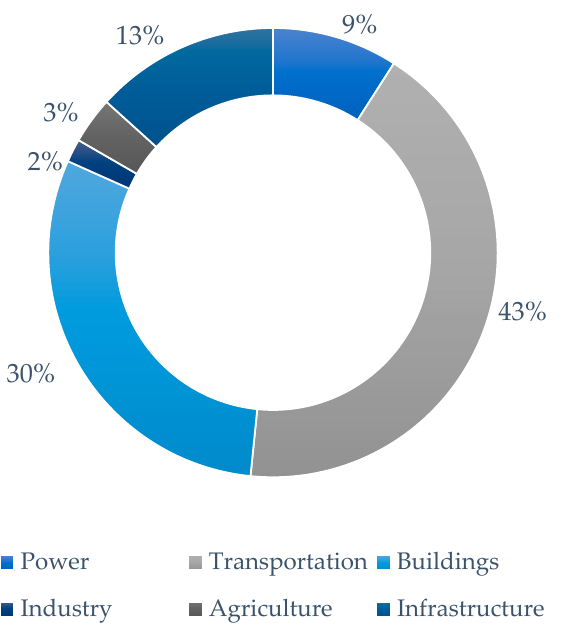
Figure 7. Total CAPEX in EU-27, broken down by sector for the period 2021 to 2050 (created using data from [137]).